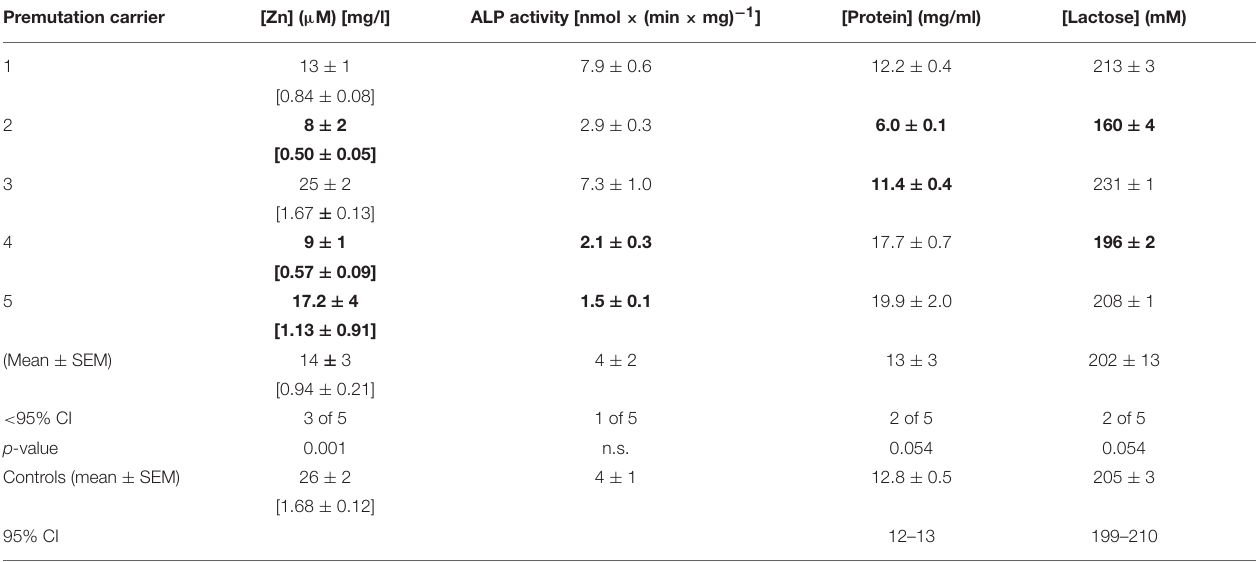
TABLE 6 | Characteristics of mature breast milk from premutation individuals. Premutation